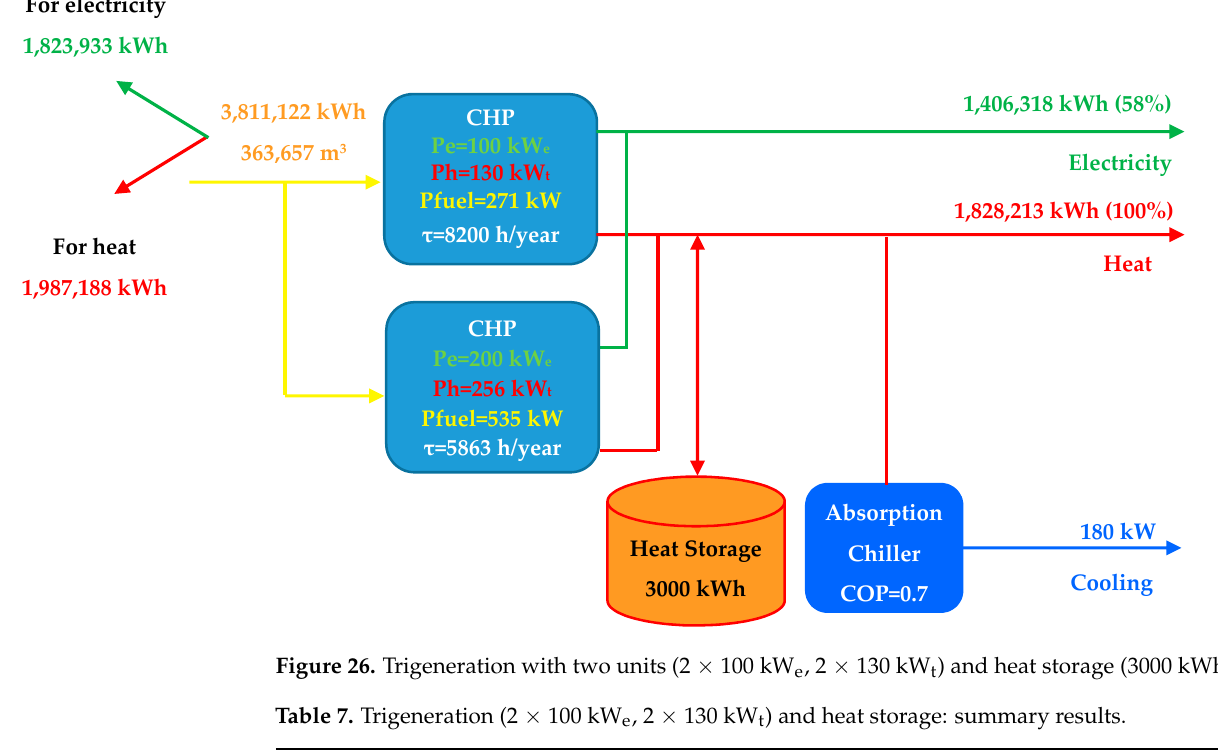
Figure 25. Trigeneration with two units, heat storage, and a peak boiler.